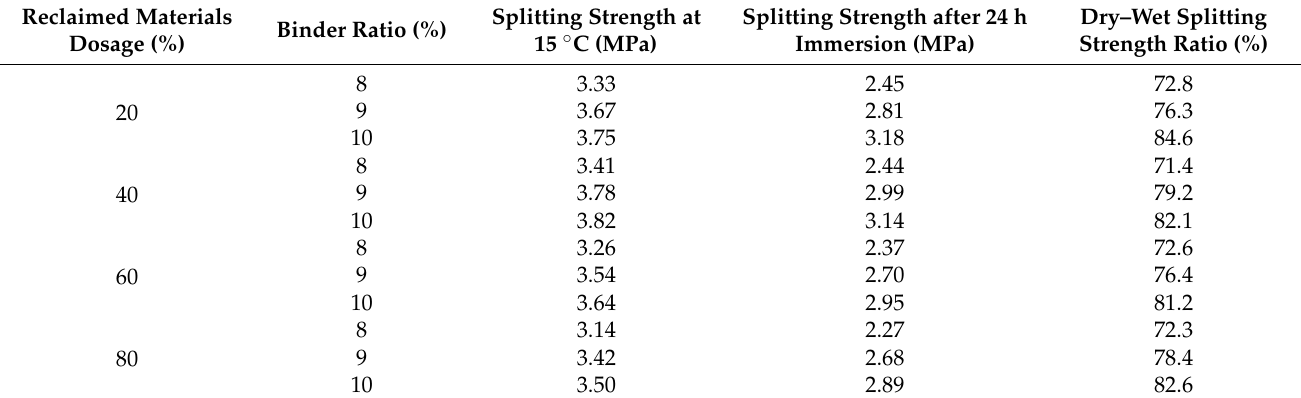
Table 6. Results of PCRM dry–wet splitting strength test with four kinds of RAP